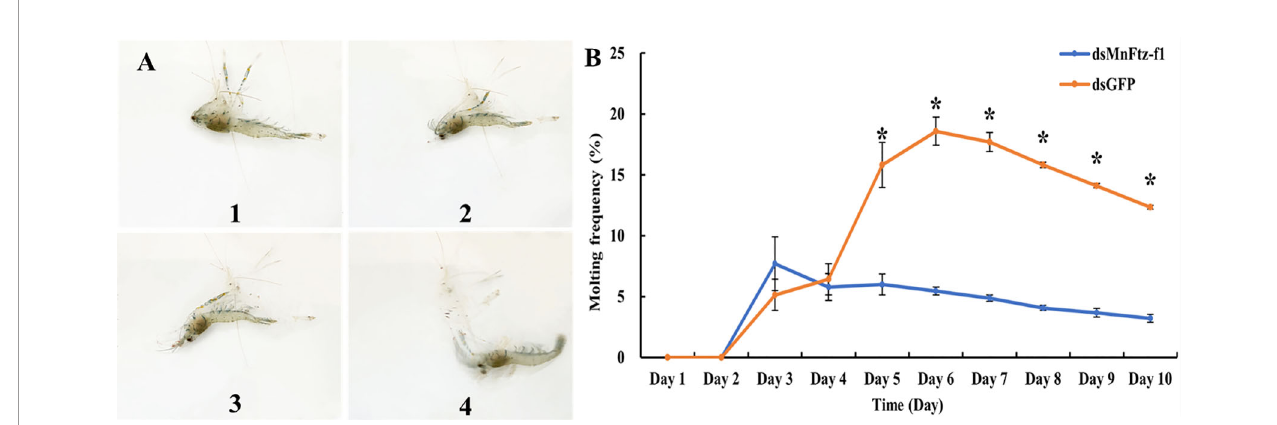
FIGURE 12 | Molting frequency of M. nipponense in the experimental and control groups after RNAi (B) . The molting order of prawn was 1- 4 (A) . GFP was used as a control. Data are expressed as mean ± SEM, and the differences were considered to be signi fi cant at P < 0.05 ( * ) by Student ’ s t